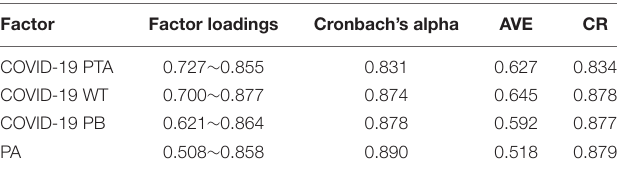
TABLE 2 | Results of reliability and